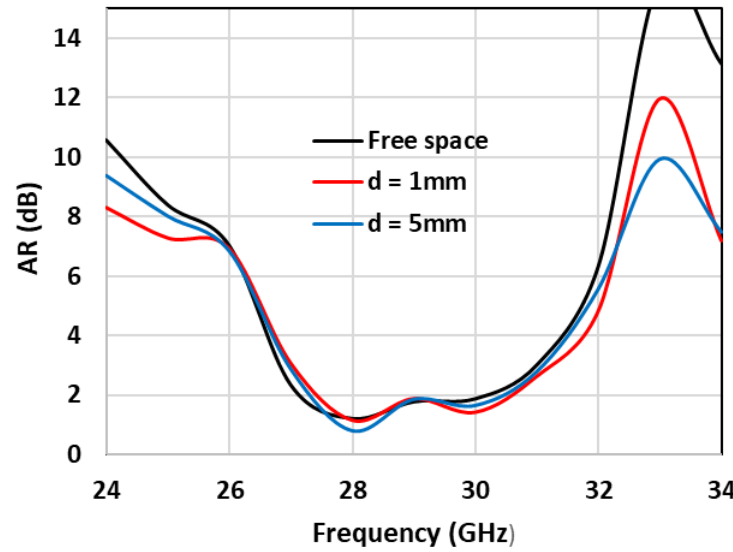
Figure 4. Axial ratio of a DRA placed in free space and next to a phantom.